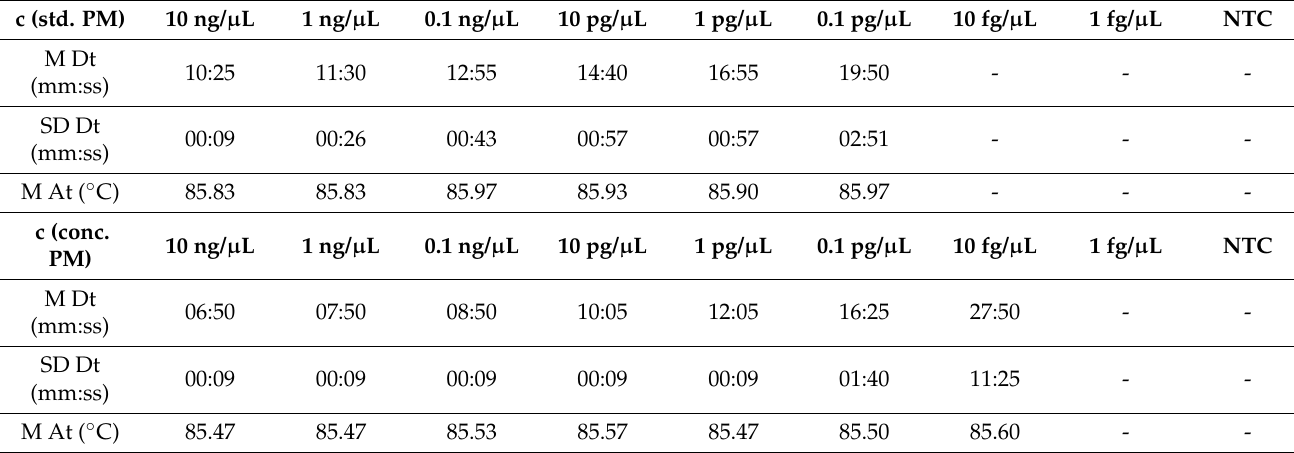
Table 4. Comparison of detection times using the standard and concentrated primer mixtures in a serial dilution (1 ng/ µ L– 1 fg/ µ L) of DNA of the reference strain G. ( H.) parasuis DSM 21448 T ( n =